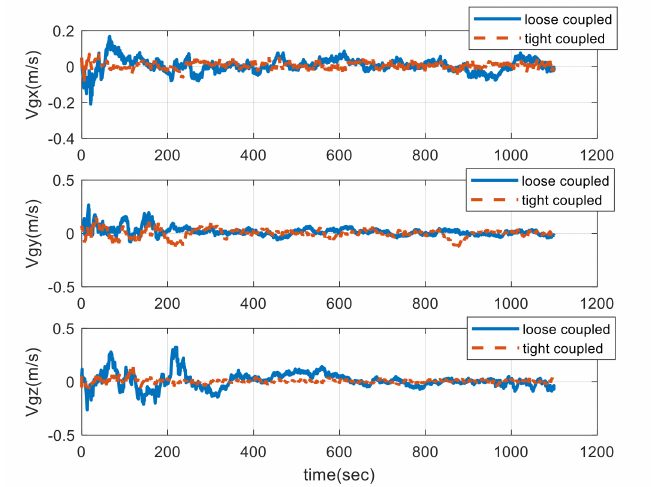
Figure 6. Comparison of velocity errors between loose and tight coupling.